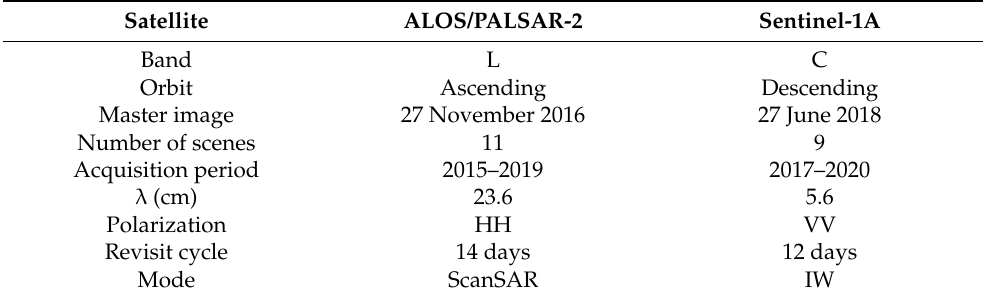
Table 1. Characteristics of ALOS/PALSAR-2 and Sentinel-1A SAR data used in this